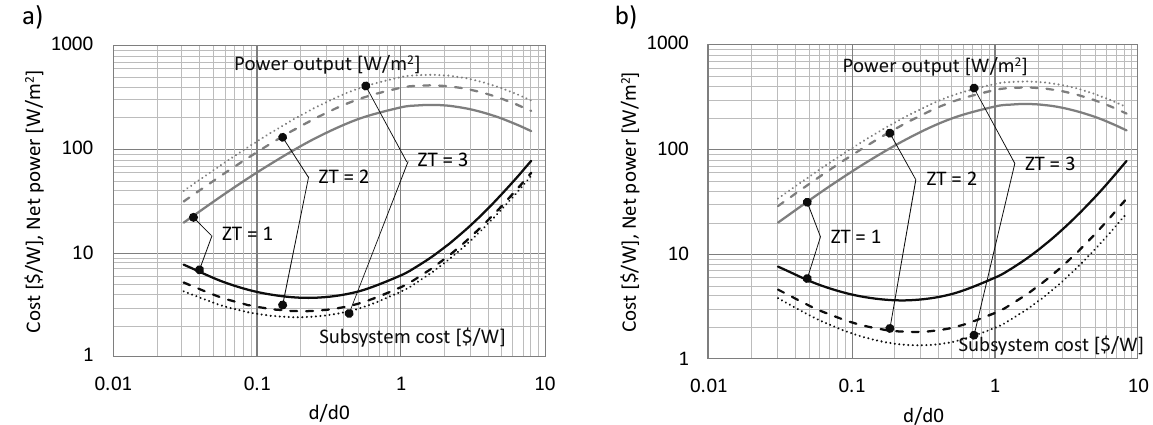
Figure 15. Subsystem cost ($/W) and power output vs leg design ( d / d 0) with varying ZT value. This result shows the case of matching heat capacities ( C g = C w ). Power output hits its peak at around 1.6 × d 0, as previously mentioned, while system cost ($/W) hits its minimum at around 0.25 × d 0. The cost per power improves significantly by reducing thermal conductivity alone compared to changing the power factor by benefitting from reducing the mass of thermoelectric material at the maximum power output design.